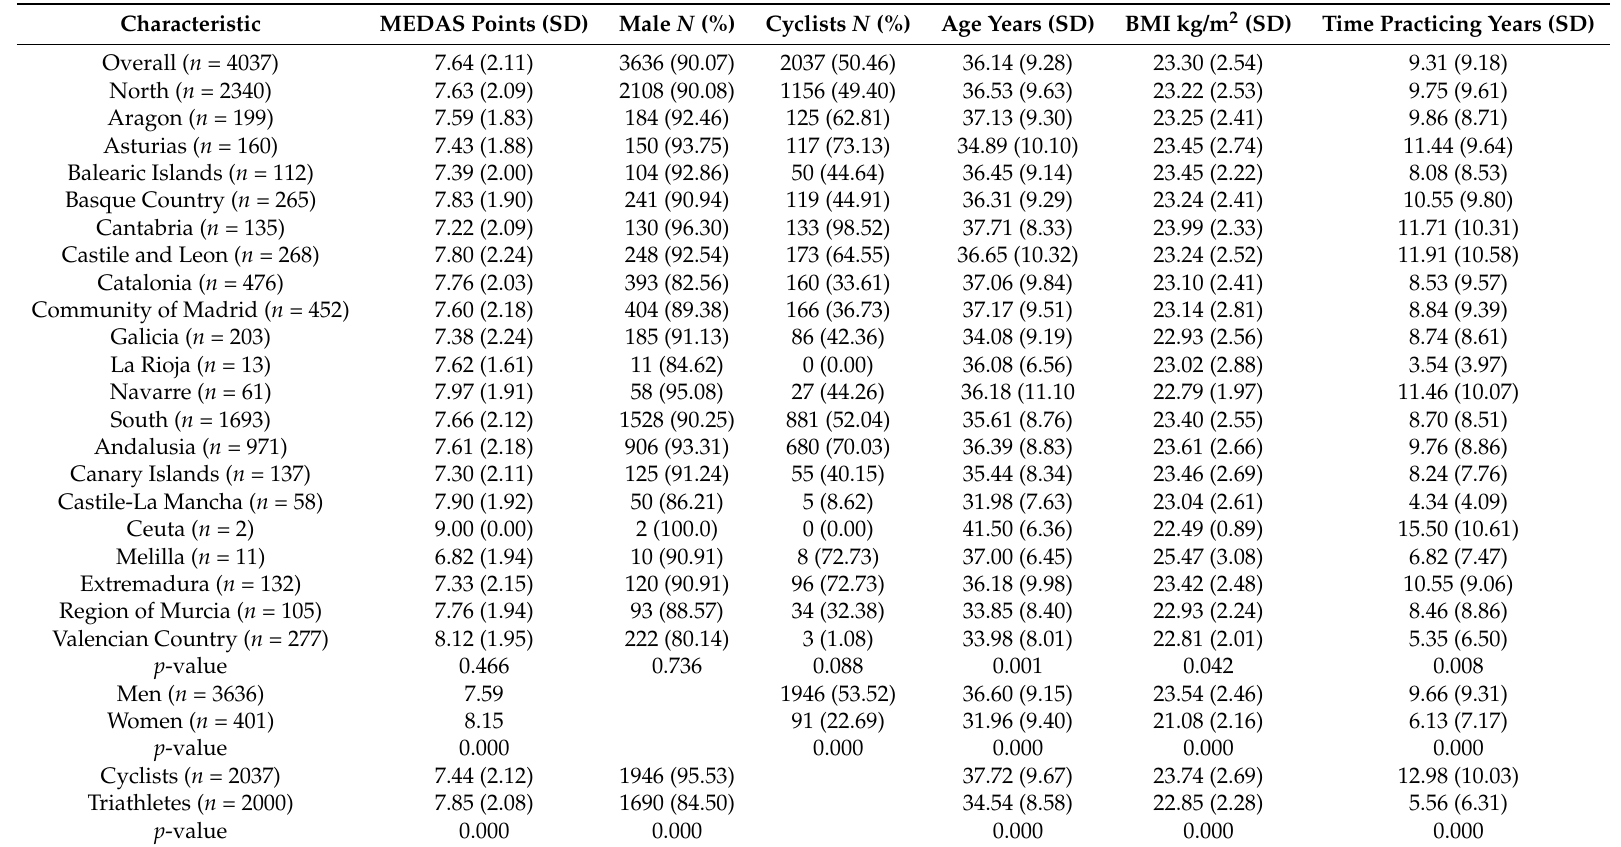
Table 1. Characteristics of study